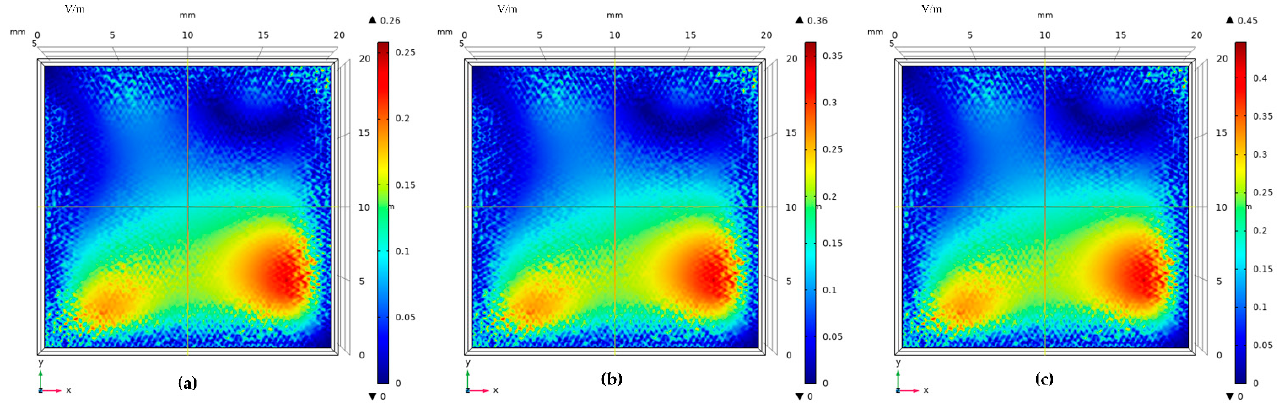
Figure 18. Surface electric field distribution of traditional copper electrode plate: ( a ) f = 30 MHz; ( b ) f = 60 MHz; and ( c ) f = 90 MHz.